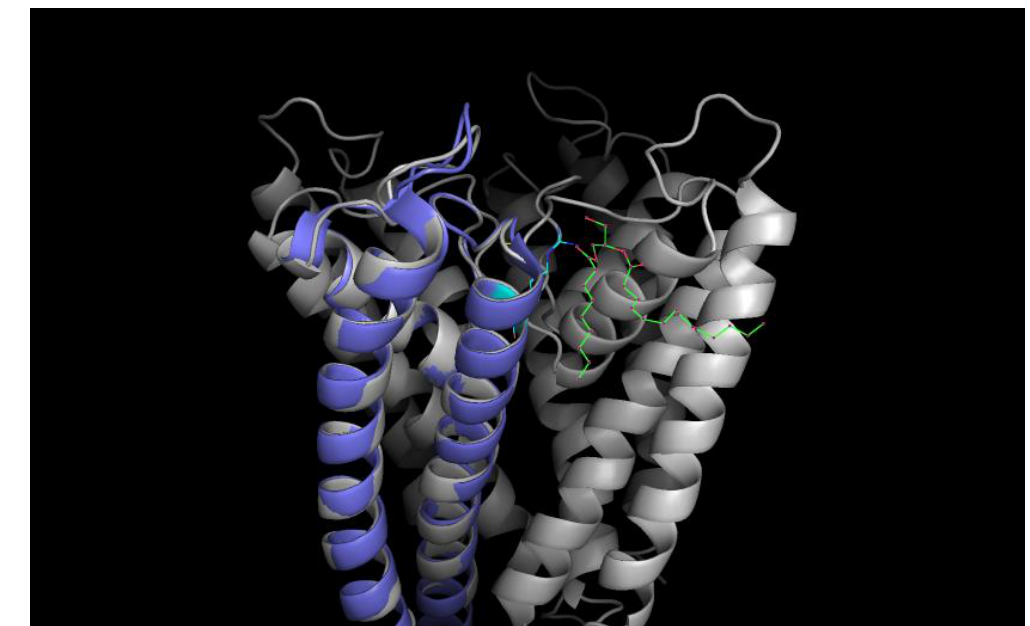
Figure 13. Cartoon of the tetrameric KcsA channel with a negatively charged non-annular lipid (diaglycerol; green-red) given in colored stick representation between the monomeric subunits electrostatically bound to the Argenine residue at position 89 (cyan–blue); one subunit colored violet for clarity. (Structural data obtained from the pdb database (PDB ID: 1k4c); edited with PyMol 1.6.0.0; Build Copyright by Schrodinger, LCC).